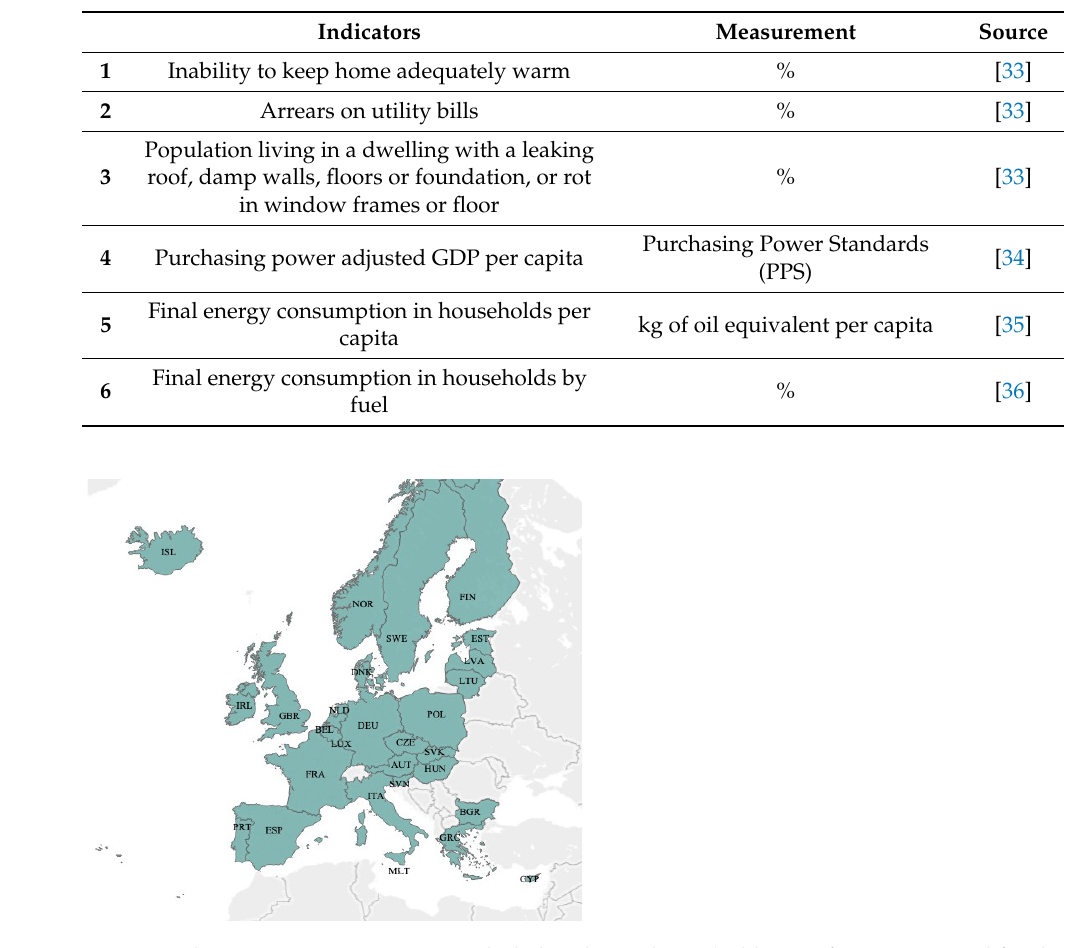
Figure 1. The 28 European countries included in the analysis. (Tableau Software was used for the creation of all presented figures).